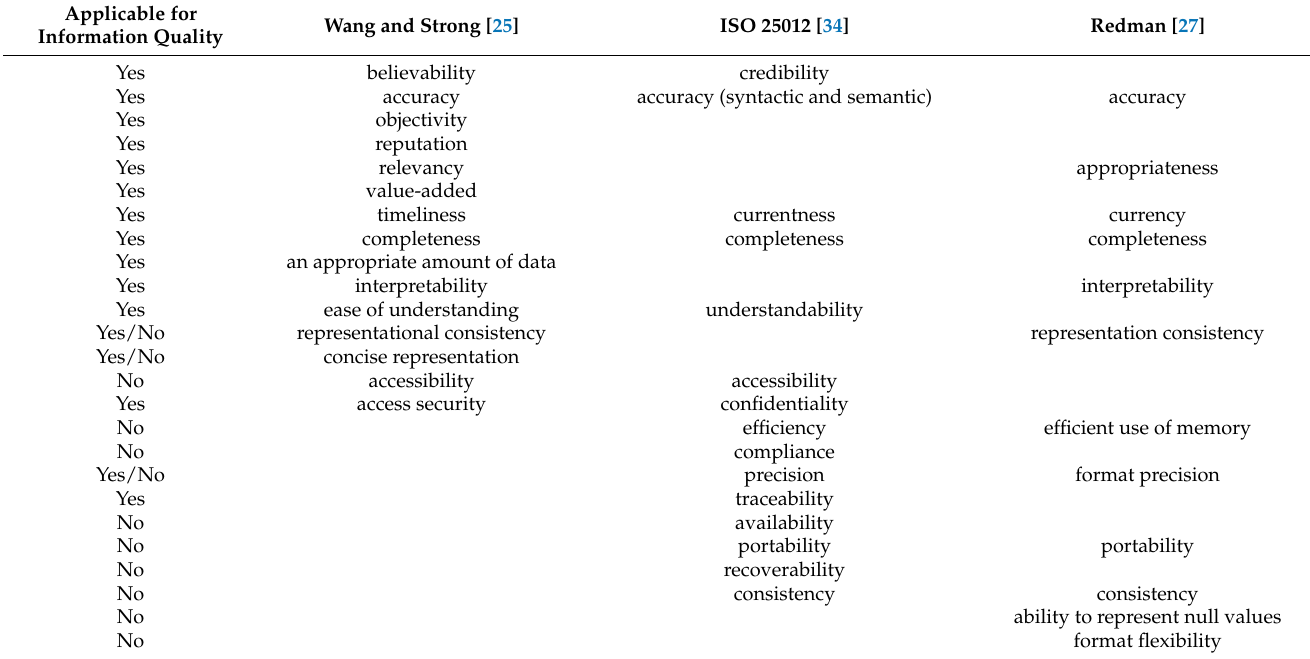
Table 1. Data quality characteristic comparison.